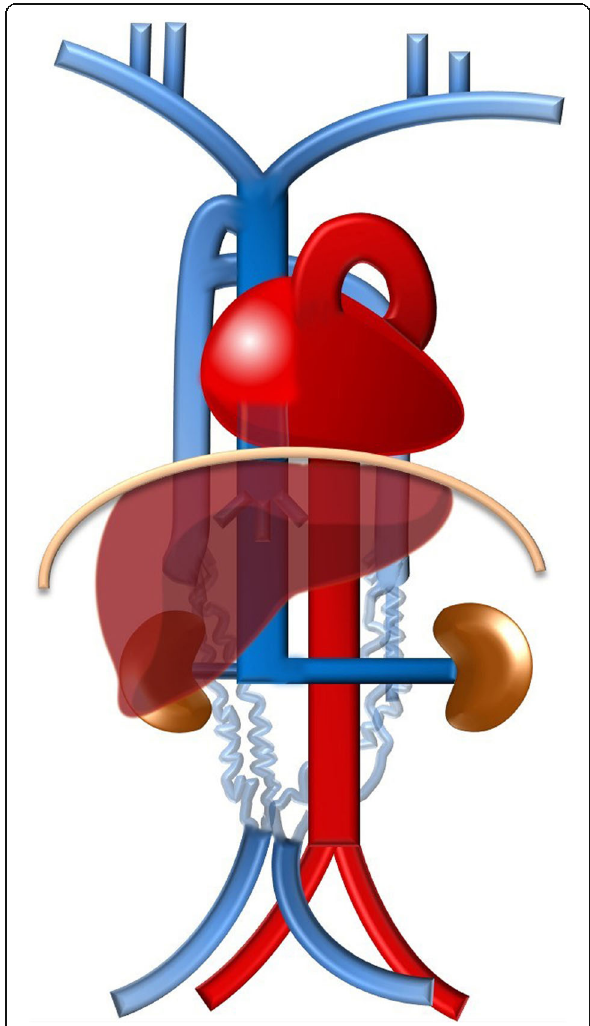
Fig. 8 Interruption of the infrarenal IVC with preservation of the suprarenal segment schematic. A rarer anomaly, subsequent to abnormal embryologic development of the posterior cardinal and supracardinal veins with resulting absence of the infrarenal segment of the IVC, in which the blood from the lower half of the body reaches the heart via the azygo-hemiazygos system of veins and prominent collateral